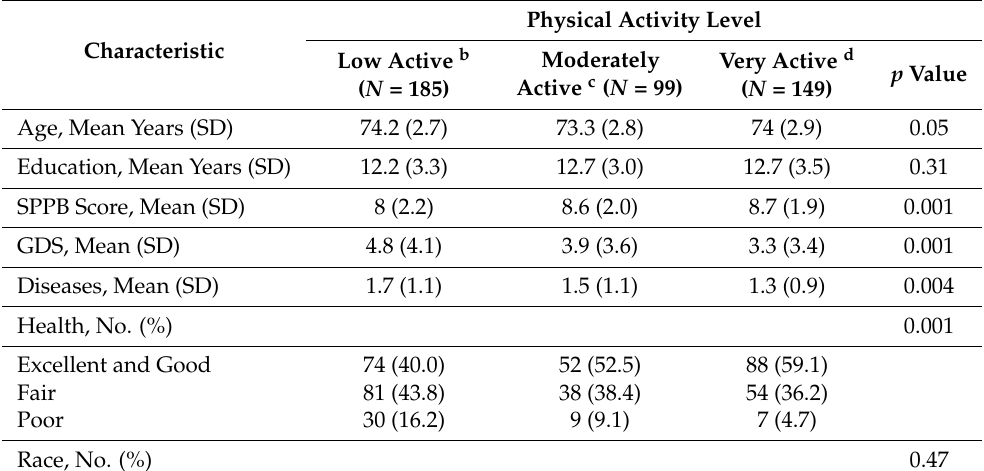
Table 2. Baseline Characteristics and Physical Activity Level in Women’s Health and Aging Study II, Baltimore, Maryland, 1994–2009 ( N = 433) a